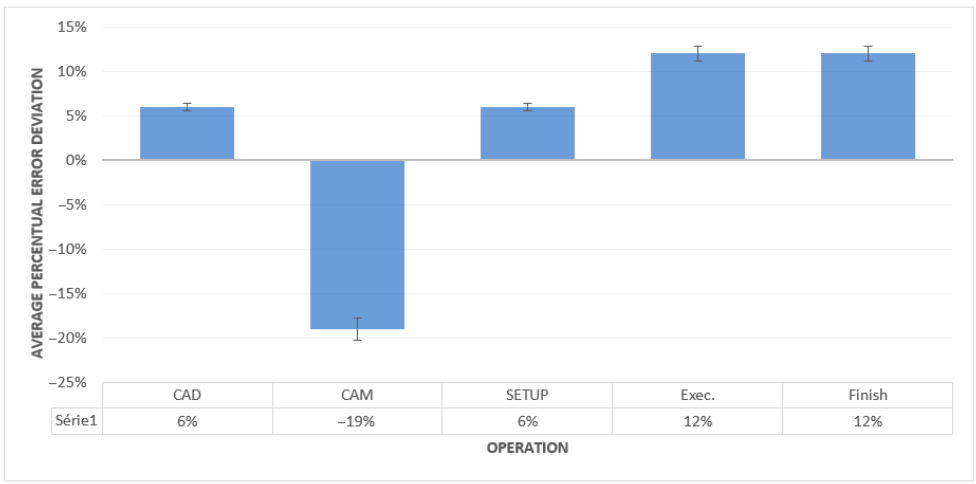
Figure 13. Average percentual deviation values for each of the production steps, for parts produced in milling centers with vacuum tables (Case Study 2).